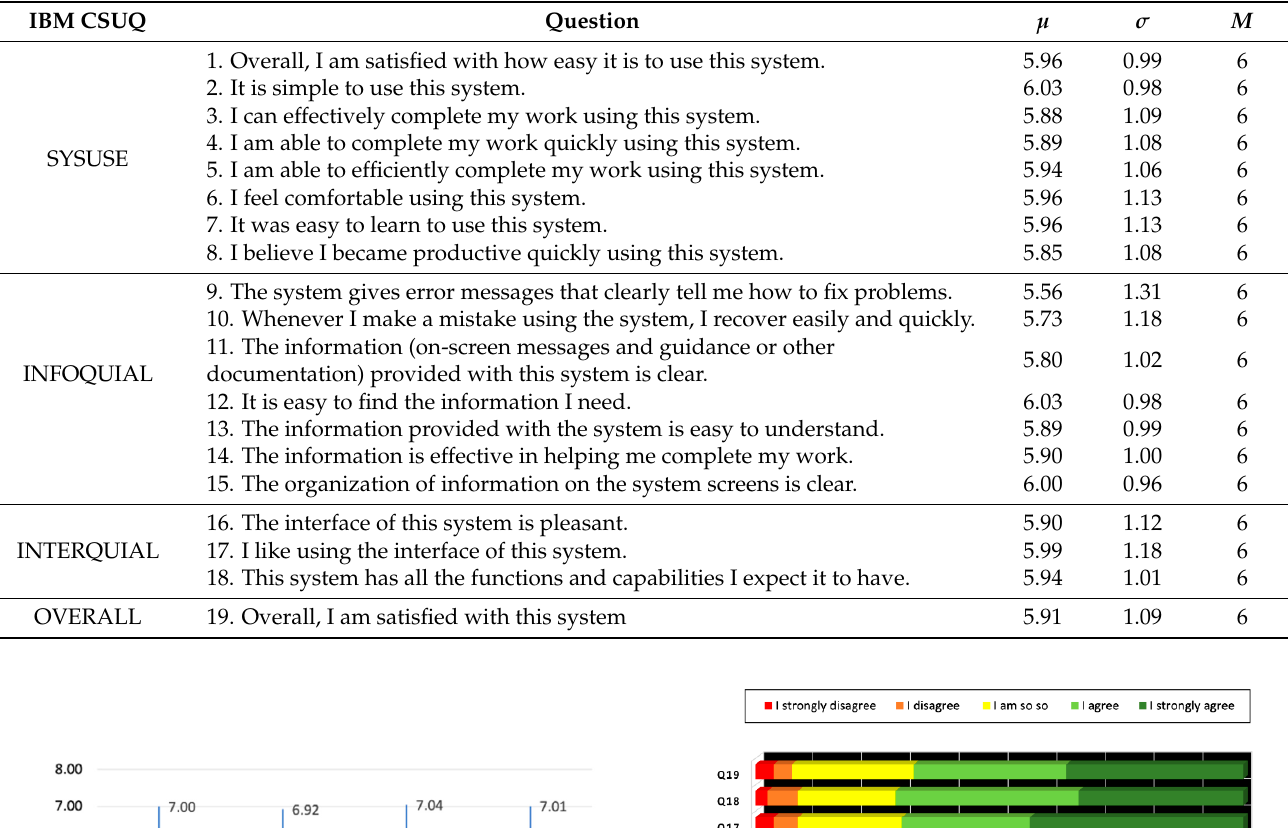
Table 3. Mean, standard deviation, and median per question.